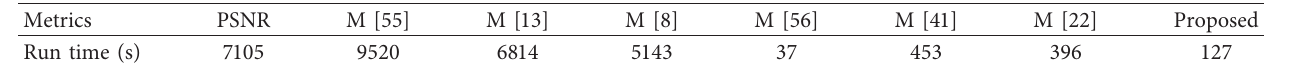
Table 8: Performance comparison of time complexity on the LIVE Phase I